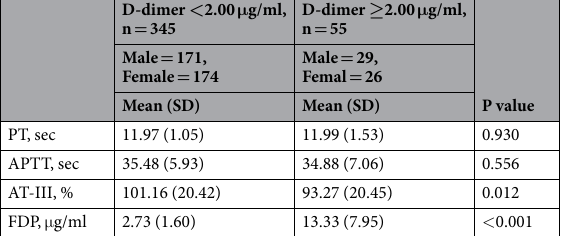
Table 3. Comparison of the Prothrombin time (PT), Activated partial thromboplastin time (APTT), Antithrombin III (AT-III) and Fibrin degradation product (FDP) of Patients With different D-dimer levels.